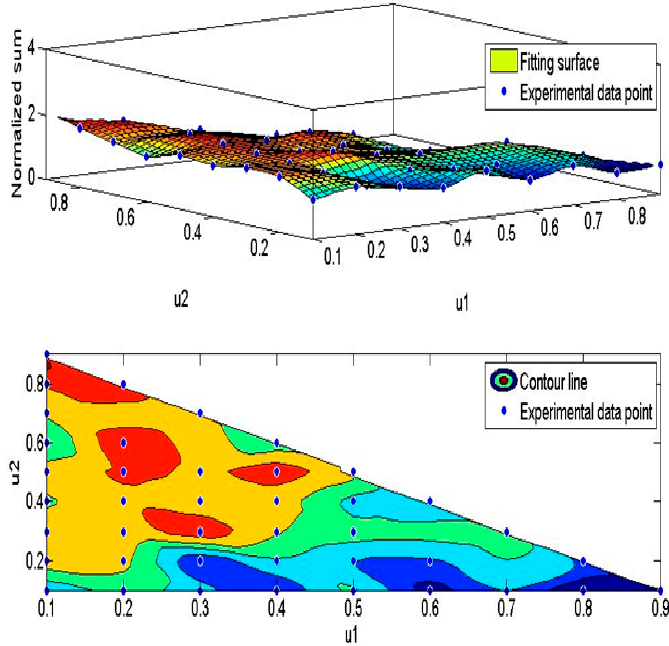
Figure 13. The distribution schematic of Normalization sum of FND and LND with different u 1 , u 2.